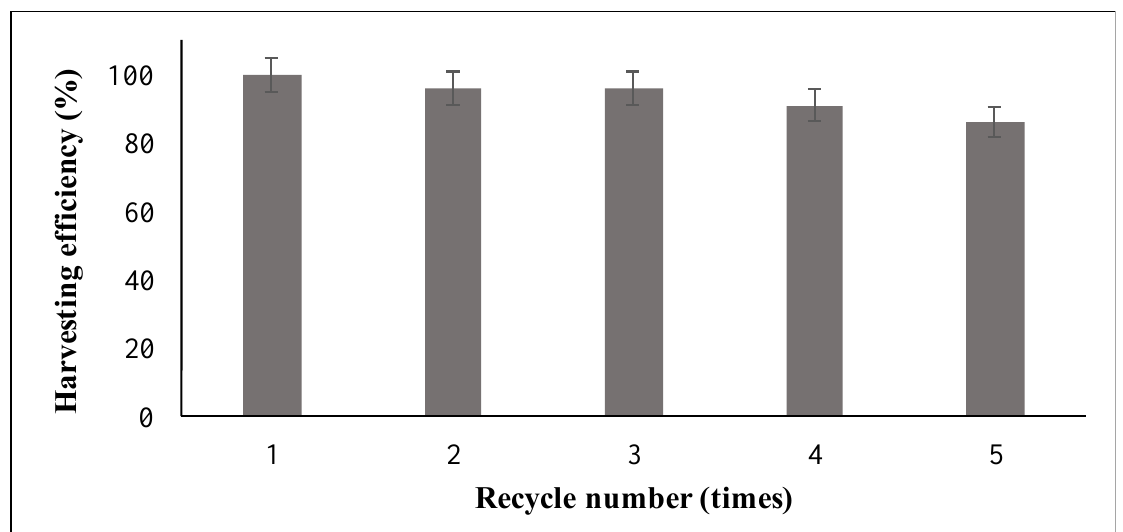
Figure 7. Chlorella vulgaris harvesting efficiency (initial concentration of 0.22 g L −1 ) at five different consecutive cycles.